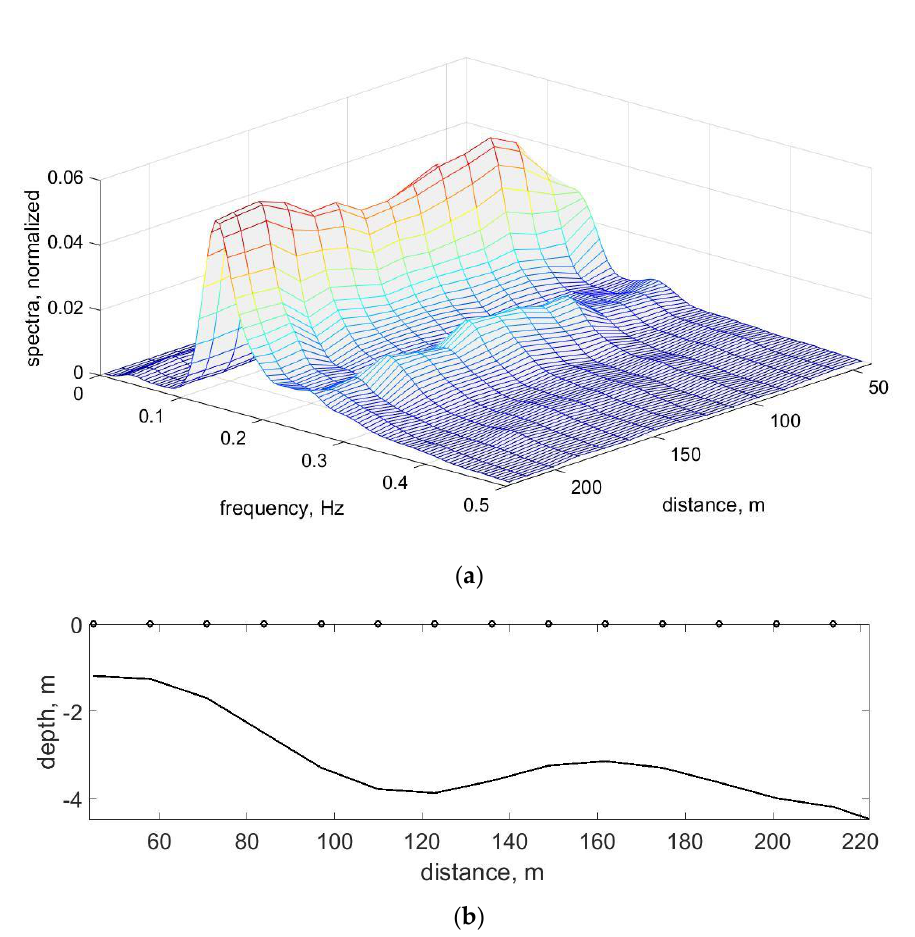
Figure 1. Periodical in space fluctuations of wave frequency spectrum normalized on wave dispersion ( a ) over the bottom profile ( b ). Field experiment Shkorpilovtsi 2007, series 62, o – positions of wave gauges.